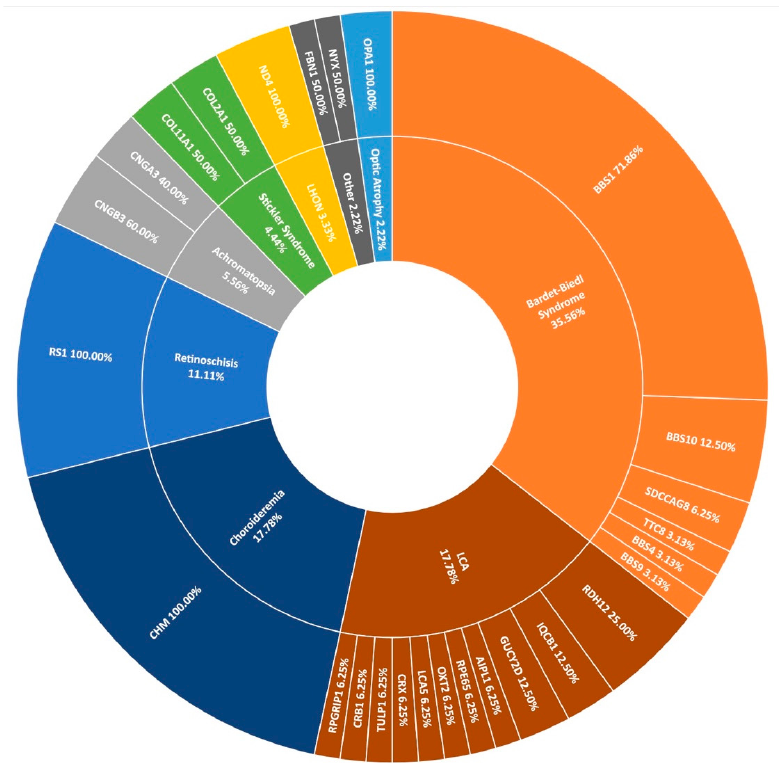
Figure 8. A summary of the genetic architecture of less common phenotypes encountered in the Target 5000 study. LCA: Leber Congenital Amaurosis, LHON: Leber Hereditary Optic Neuropathy (Table S7).